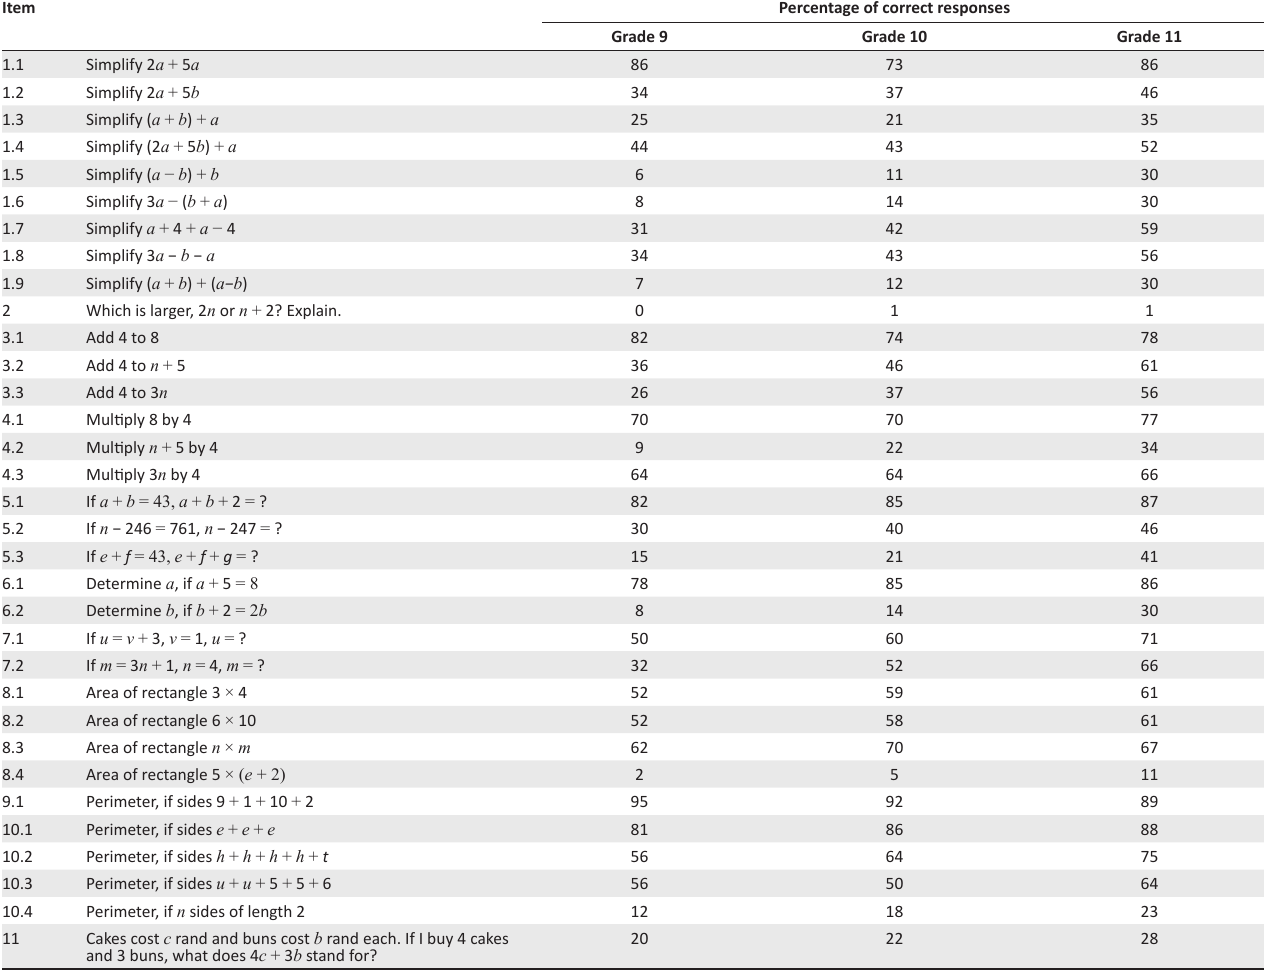
TABLE 1: Percentage of correct responses to each item per grade.